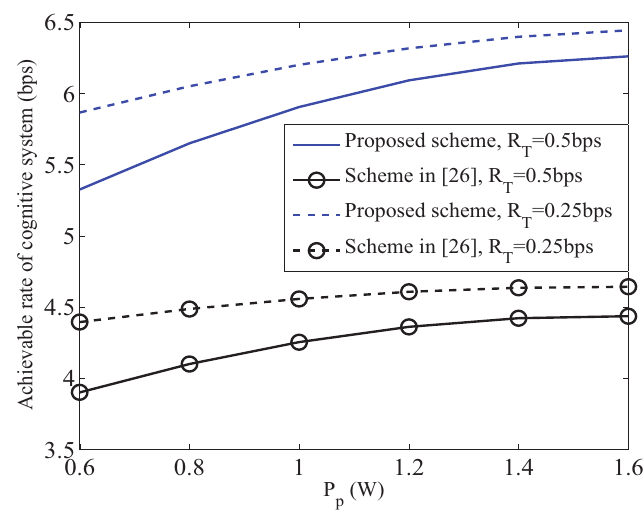
Figure 3. Achievable rate of cognitive system versus P p .